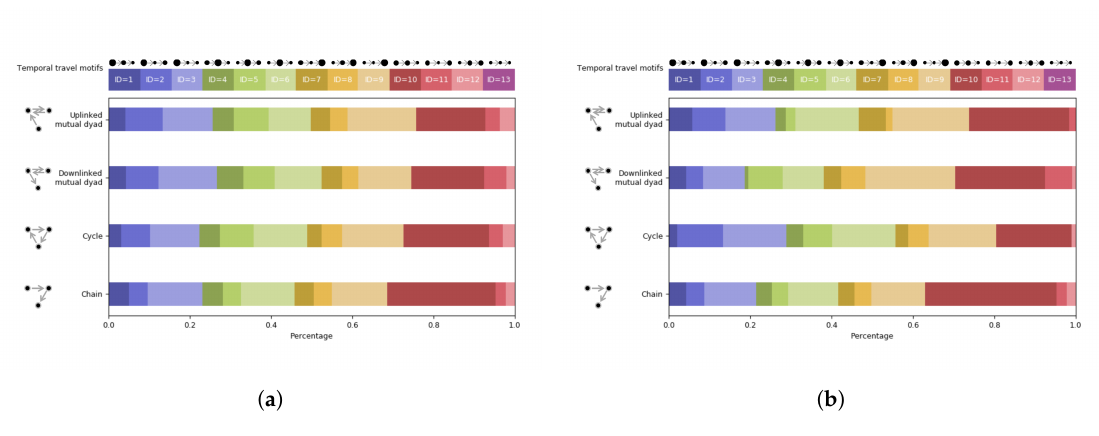
Figure 4. Statistical characteristics of temporal travel motifs based on ( a ) discrete sequence and ( b ) consecutive